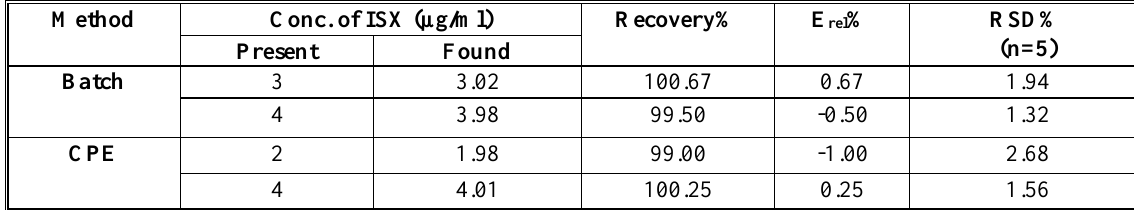
Table 3. Accuracy and repeatability for batch and CPE methods Method